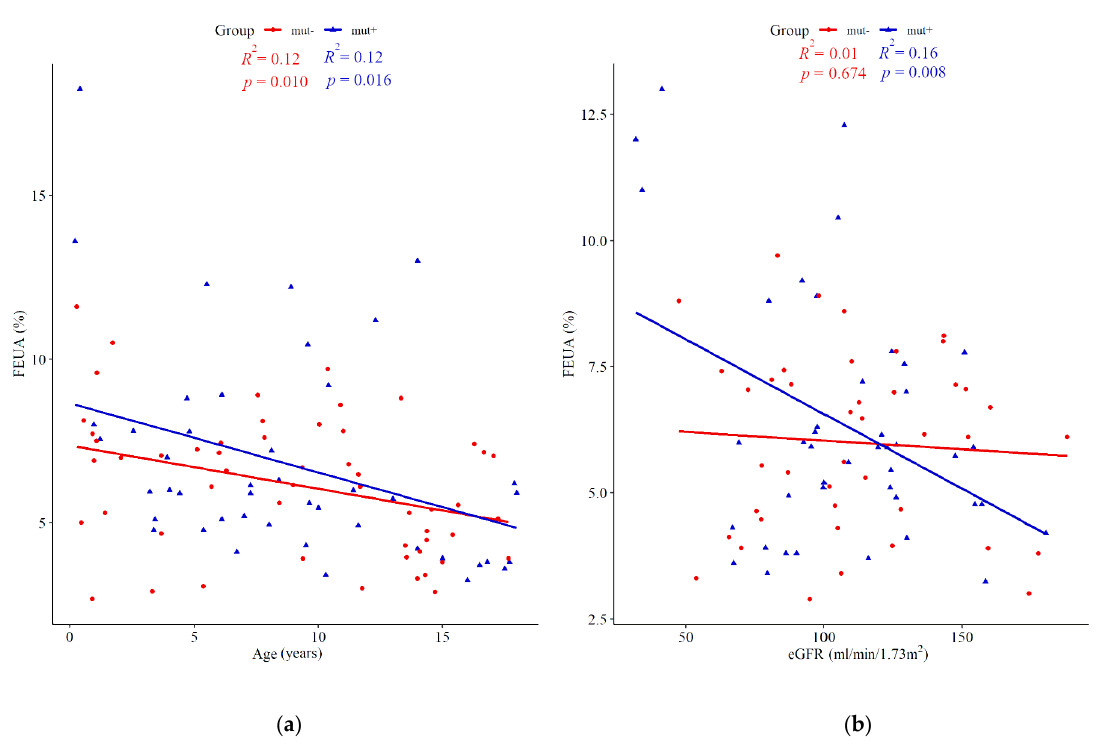
Figure 3. Fractional excretion of uric acid (FEUA) according to age ( a ) versus estimated glomerular filtration rate (eGFR) ( b ) in the HNF1B positive cohort (mut+, blue triangles) and HNF1B negative cohort (mut-, red dots).